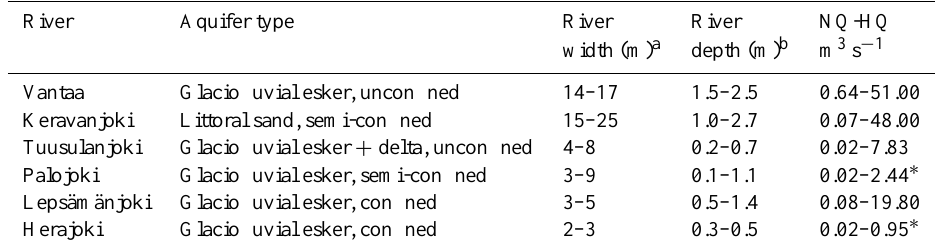
Table 1. Field measurement study sites and their characteristics. Data on river flow rates, mean flow discharge (NQ) and mean high dis- charge (HQ) based on 2002–2012 data from the HERTTA database, except for the rivers Palojoki and Herajoki, which are based on flow measurements in 2011–2012 ∗